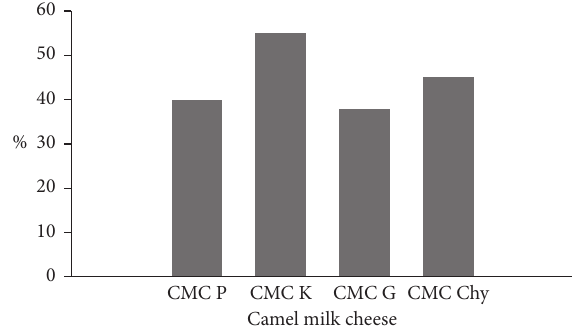
Figure 4: Preference test of camel cheese with different extracts. CMC P: camel milk cheese with pineapple; CMC K: camel milk cheese with kiwi; CMC G: camel milk cheese with ginger; CMC Chy: camel milk cheese with